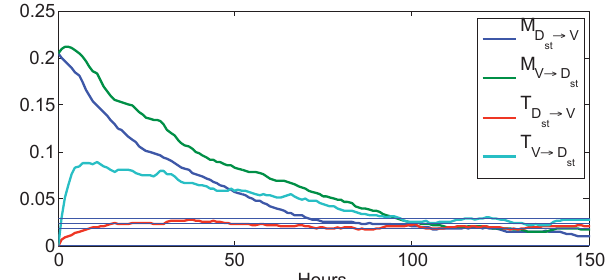
Figure 2. Comparison of mutual information and transfer entropy measures to determine causal driving of the magnetosphere as char- acterized by D st . Note that causal driving appears to peak some- what later (11h) than indicated by mutual information (2h), indi- cating that internal dynamics likely are very important initially. The backward transfer entropy is below the noise level for all values, indicating that D st in no way influences the upstream solar wind velocity. Such a conclusion could not be inferred from the mutual information